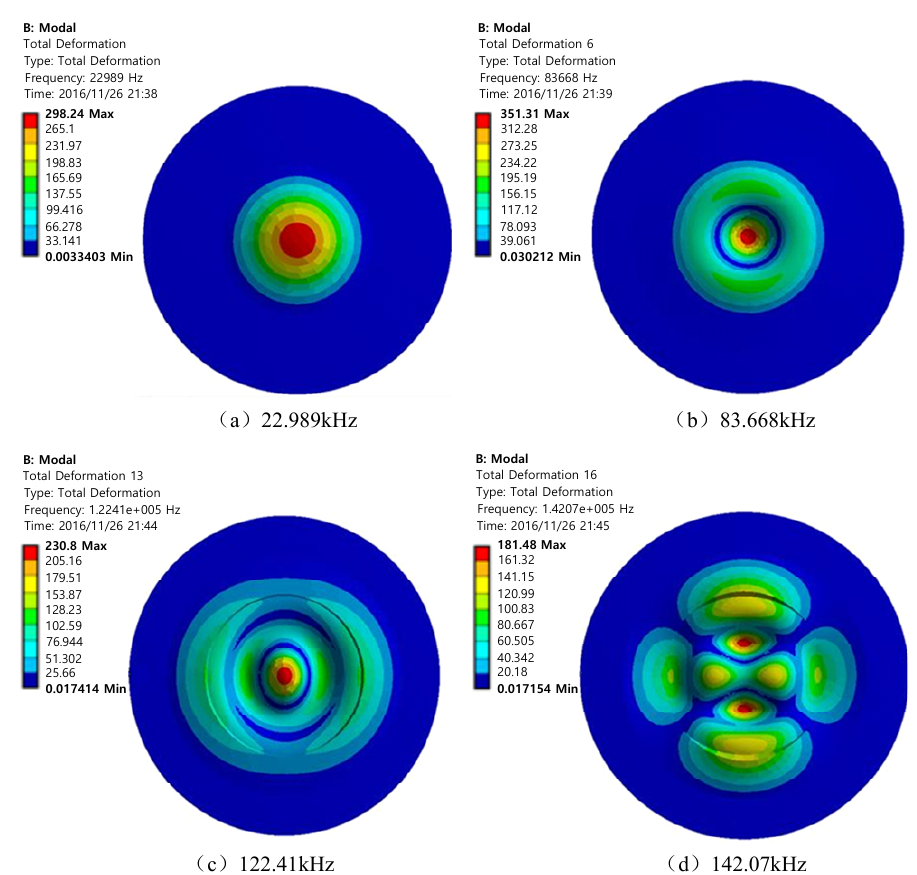
Figure 3. Simulation diagram of the vibration mode of a piezoelectric vibrator.